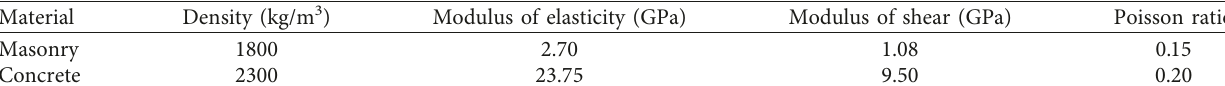
Figure 9: Analytical model of the masonry building. (a) Masonry building. (b) Section of the first floor. (c) Section of the second floor. Table 2: Mechanical properties of building materials.